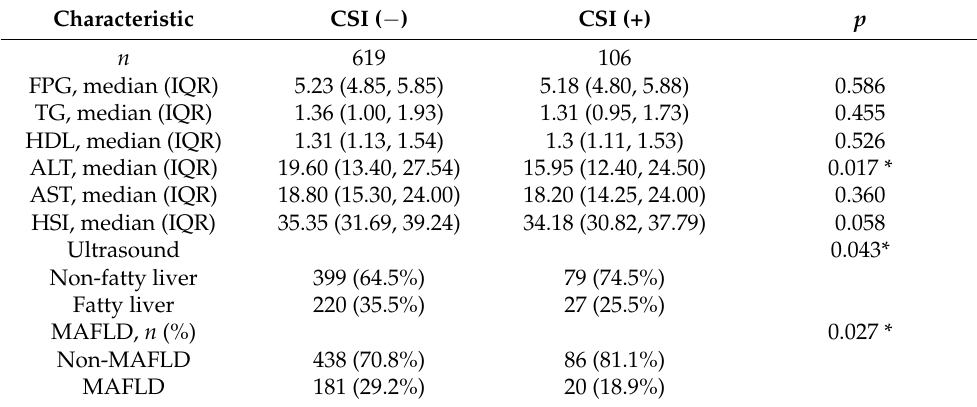
Table 2. Clinical Biochemical or Imaging Indicators with CSI among EC